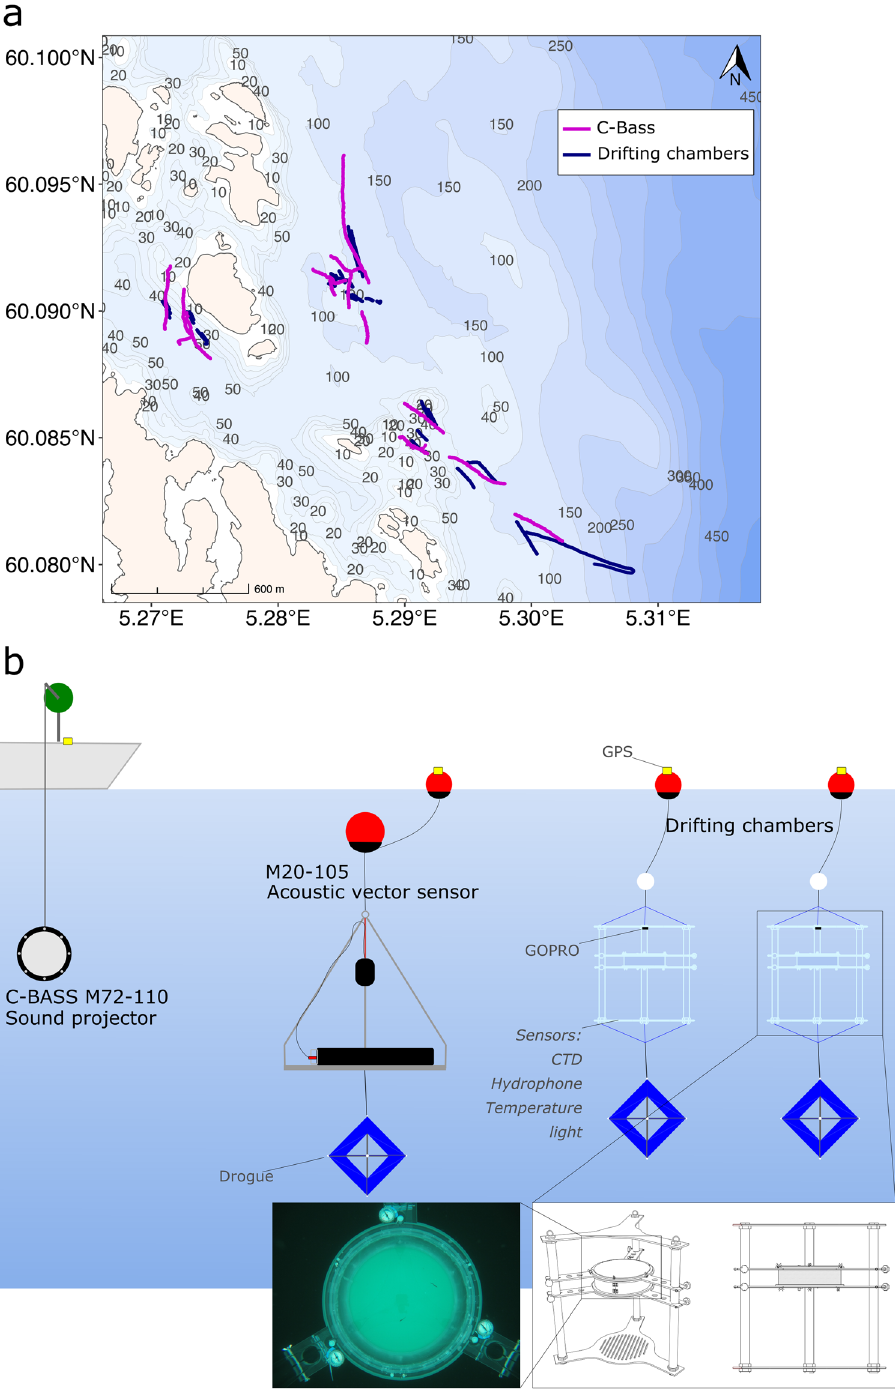
Fig. 1 Area where the experiments on Atlantic cod ( Gadus morhua ) larvae were conducted and experimental setup. a Map with the location where experiments were performed. The map shows the coastline and bathymetry (coastline and bathymetry layers from the open-source repository www. kartverket.no). Magenta lines are the GPS tracks of the C-Bass sound projector and navy-blue lines are the GPS tracks of the drifting chambers containing fi sh larvae. All of the tests were performed at a distance of <200 m between the C-Bass and the chambers. During any given test, both chambers were deployed at the same time, each one containing two cod ( Gadus morhua ) larvae. In total, we video-recorded the behavior of 89 cod larvae. b Schematic diagram of the experimental design. The sound projector (C-Bass M72-110, GeoSpectrum Technology Inc. (GTI)), the acoustic vector sensor (M20-105, GTI), and the drifting chambers were all out fi tted with drogues and drifted independently. The projector, the acoustic vector sensor, and the circular arena of the drifting chambers were all at 5 m depth. The chambers were equipped with an array of sensors (CTD, hydrophone, temperature, light) placed on the bottom grid of the acrylic frame. The bottom-right white box shows the technical drawings of the drifting chambers, with a picture showing the view from the GOPRO mounted on the frame that recorded the videos used for the tracking of the larvae, which are clearly visible.